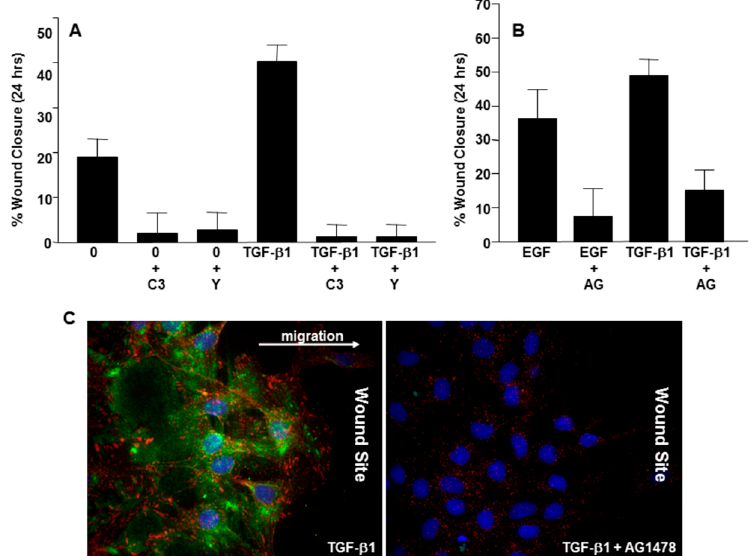
Figure 3. Signaling requirements for VSMC monolayer scratch would closure. Confluent VSMC cultures were scrape-wounded with a pipette tip prior to addition TGF- β 1 or EGF with ( + ) or without a 30 min pre-incubation with the Rho GTPase inhibitor C3 transferase (C3), the ROCK inhibitor Y-27632, or the EGFR kinase inhibitor AG1478. C3 transferase and Y-27632 effectively attenuated both basal and TGF- β 1-stimulated VSMC migration ( A ) and AG1478 significantly reduced EGF as well as TGF- β 1 induced migration ( B ) in response to monolayer wounding. In TGF- β 1-treated cultures, PAI-1 expression was evident at the wound edge within hours post-injury ( C , left panel ). PAI-1 induction was completely inhibited by exposure to AG1478 ( C , right panel ) correlating with a significant reduction in cell migration ( B ).